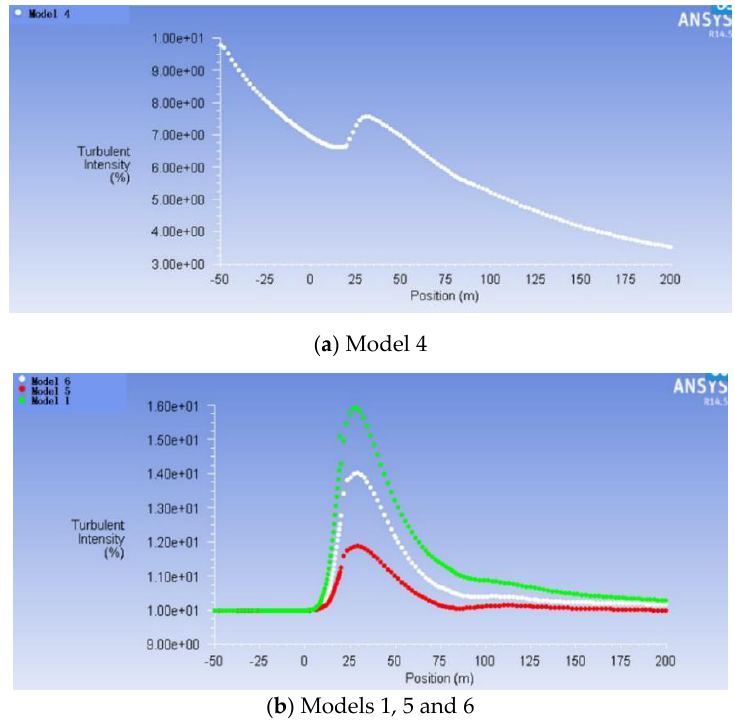
Figure 12. The turbulence of different models at the central axis.